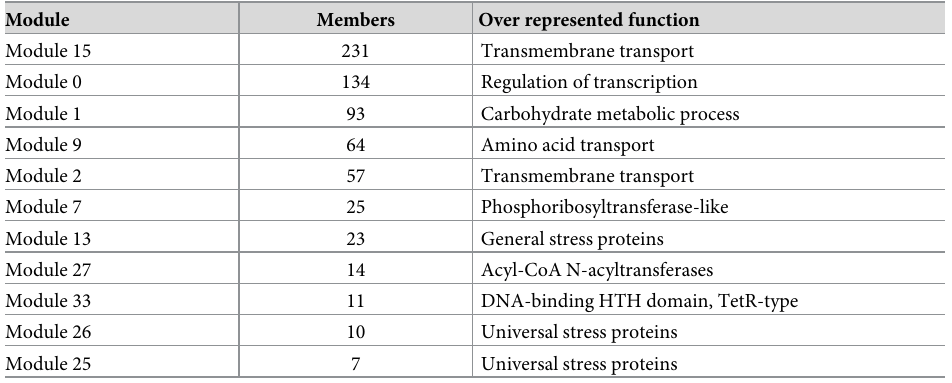
Table 1. Enrichment of the most representative biological processes in the modules of the L . lactis MG1363